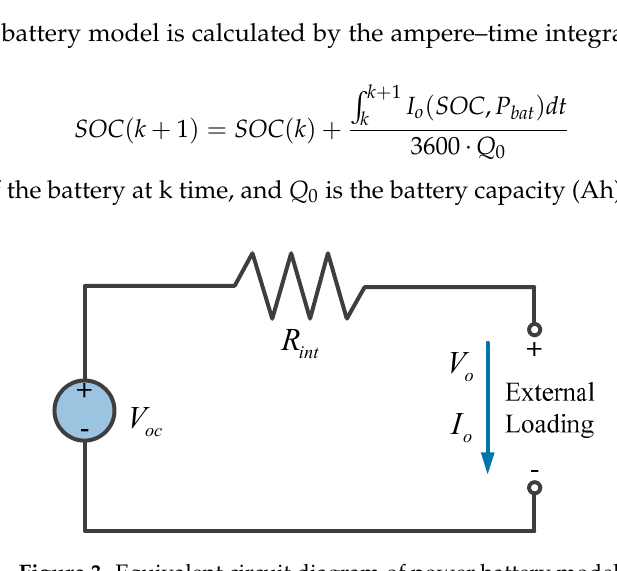
Figure 3. Equivalent circuit diagram of power battery model.